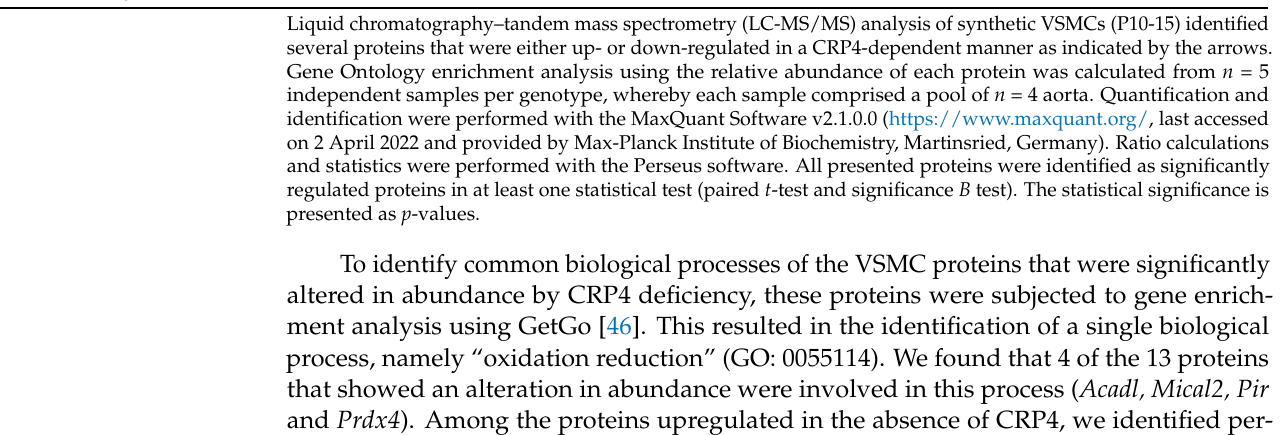
Table 1. Proteomic analysis of P10-15